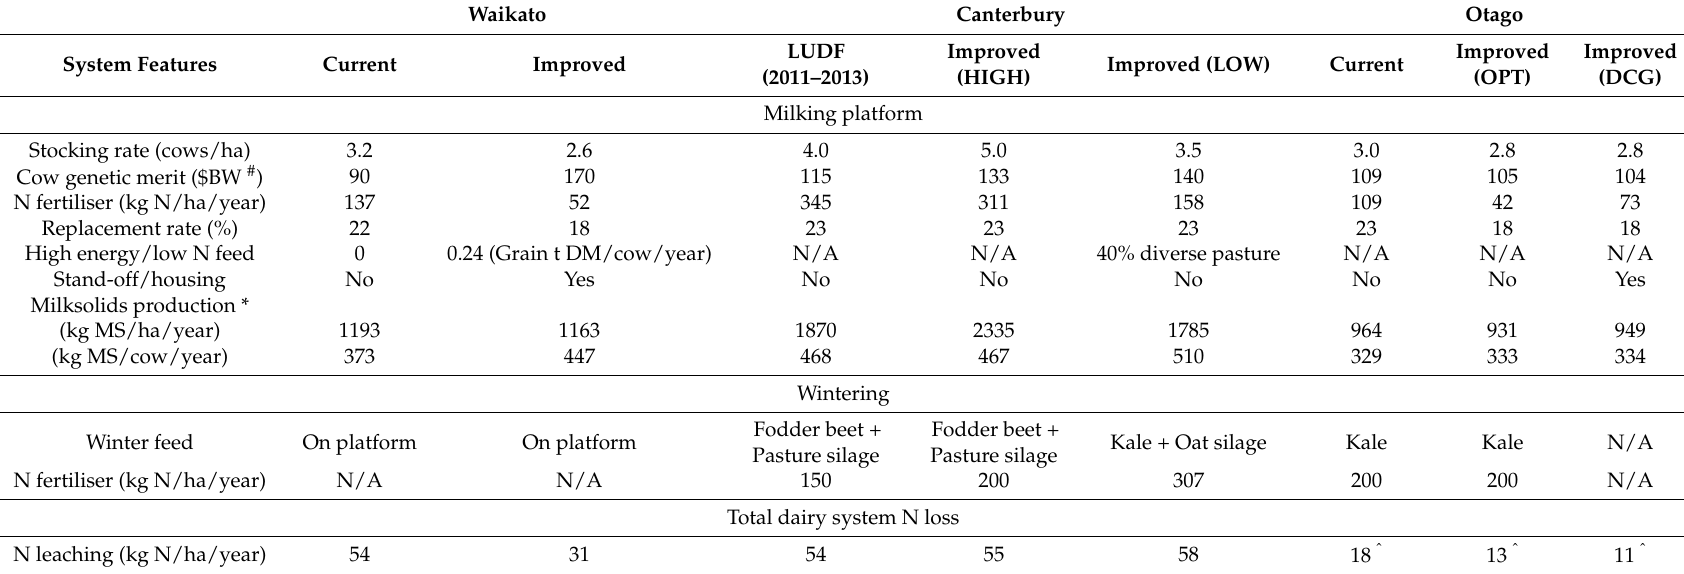
Table 2. Key management features of ‘current’ and ‘improved’ systems in Canterbury, Waikato, and Otago for assessing differences in, and key drivers of, GHG emissions from dairy systems. Estimated N leaching losses are also included [7,16,27]. HIGH and LOW = high and low stocking rate; OPT = optimised feeding and DCG = duration controlled grazing. See text for further descriptions of each